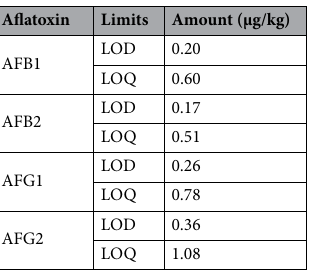
Table 2. Limits of Detection and Quantification (LOD & LOQ) of aflatoxins AFB 1 , AFB 2 , AFG 1 , AFG 2 and Total aflatoxins (µg/kg) measured by HPLC. LOD limit of detection, LOQ limit of quantification.